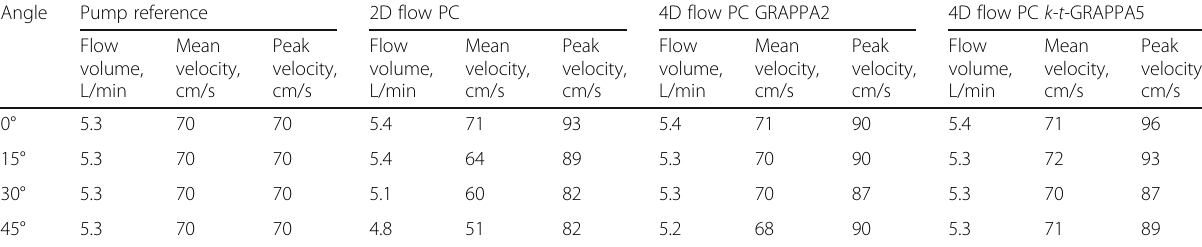
Table 4 Distribution of measurements of the flow volumes, mean velocity, and peak velocity for two different 2D flow phase-contrast acquisitions (orthogonal “ through-plane ” to the phantom vessel and misaligned) and two 4D flow phase-contrast sequences (GRAPPA2 and k-t- GRAPPA5) with angles between the longitudinal axis of the phantom vessel and the z -direction in 15° steps from 0 to 45°